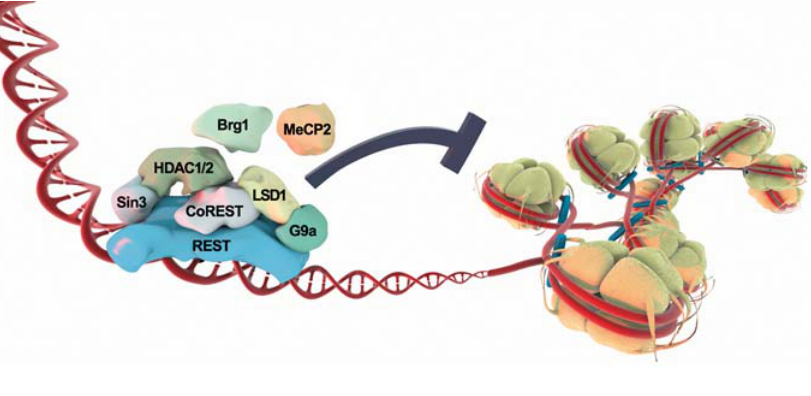
Figure 1. REST Repression Is Associated with Many Different Transcriptional Coregulators A schematic model of REST interactions with some selected transcriptional coregulators and chromatin modifying proteins. HDAC1/2 deacetylate lysine 9 on histone H3 (H3K9), and low acetylation and high methylation of this lysine when situated in a promoter close to a transcription start site is associated with transcriptional repression. The histone demethylase LSD1 represses transcription by demethylating lysine 4 on histone H3 (H3K4). H3K4 is a residue that, when (tri)methylated, attracts and recruits transcription initiation factors, and thus H3K4 methylation is associated with transcriptional activation, in contrast to, e.g.,